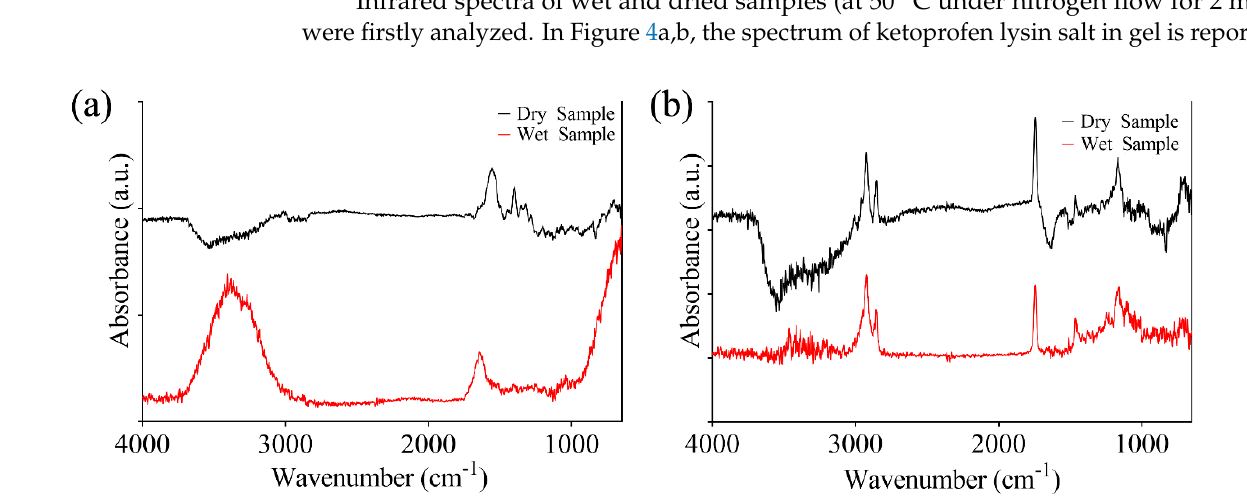
Figure 4. Comparison between spectra obtained from wet and dry sample of ketoprofen lysine salt and excipients ( a ), and KiOil ( b ).